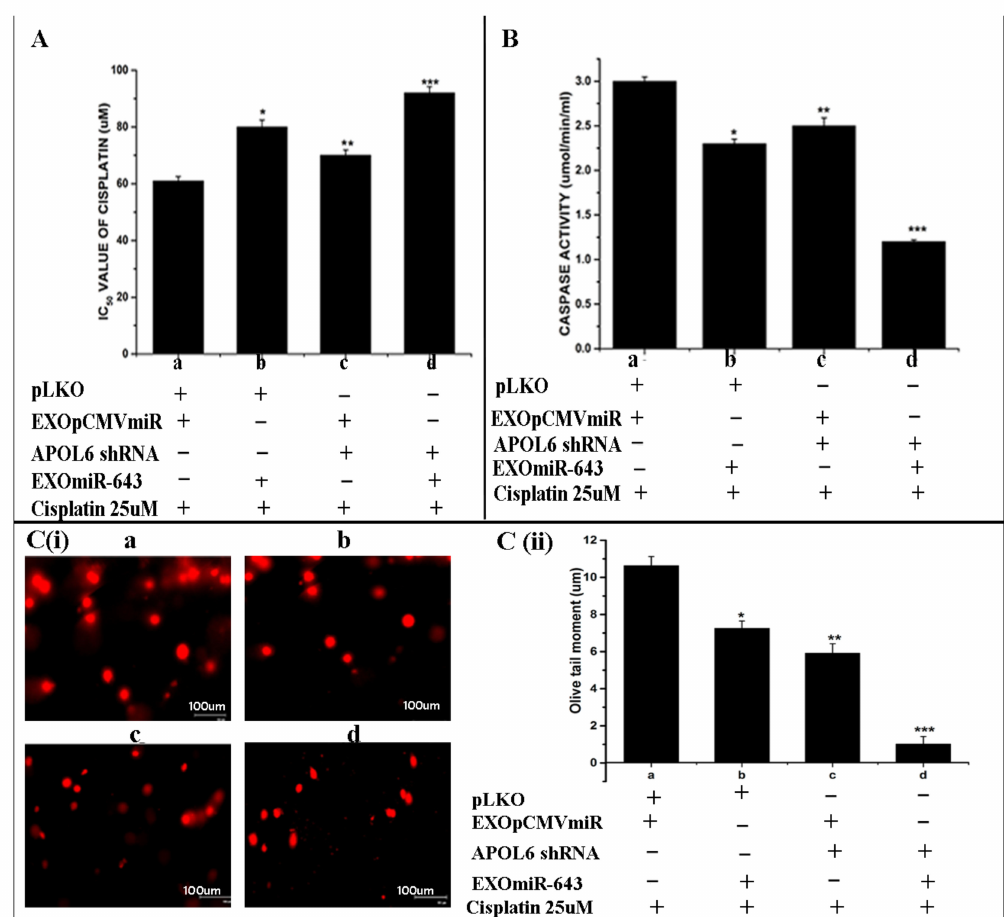
Figure 10. Effect of APOL6 knockdown on miR-643-mediated alteration in cisplatin resistance. APOL6 knocked down cells were treated with 100 µ g of miR-643 exosomes in the presence of cisplatin (25 µ M) followed by XTT assay, comet and caspase 3 activity assay. ( A ) Cytotoxicity assay ( B ) Caspase 3 activity assay ( C ) ( i ) Representative microphotographs of comets ( C ) ( ii ) Levels of DNA damage analysed by comet assay using opencomet software. In ( A – C ), a—represents pLKO vector control + EXO (pCMVmiR) + cisplatin, b—represents pLKO vector control + EXO miR-643 + cisplatin, c—represents APOL6 shRNA + EXO pCMVmiR + cisplatin, d—represents APOL6 shRNA + EXO miR-643 + cisplatin. The mean values of two different experiments ± SEM each performed in triplicate are reported in the graph, p < 0.05. * indicates statistical significance when compared to a. ** indicates statistical significance when compared to b. *** indicates statistical significance when compared to